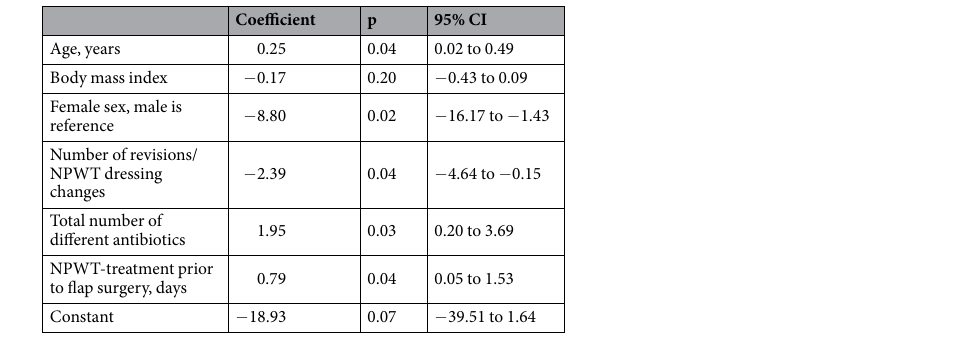
Table 4. Logistic regression for flap loss and complications. Multivariable logistic regression pseudo R 2 0.58, Model p < 0.001, n = 41. Flap loss and complications (n = 21) are coded as 1. Flap success with no complications are coded as 0. NPWT = Negative pressure wound therapy.